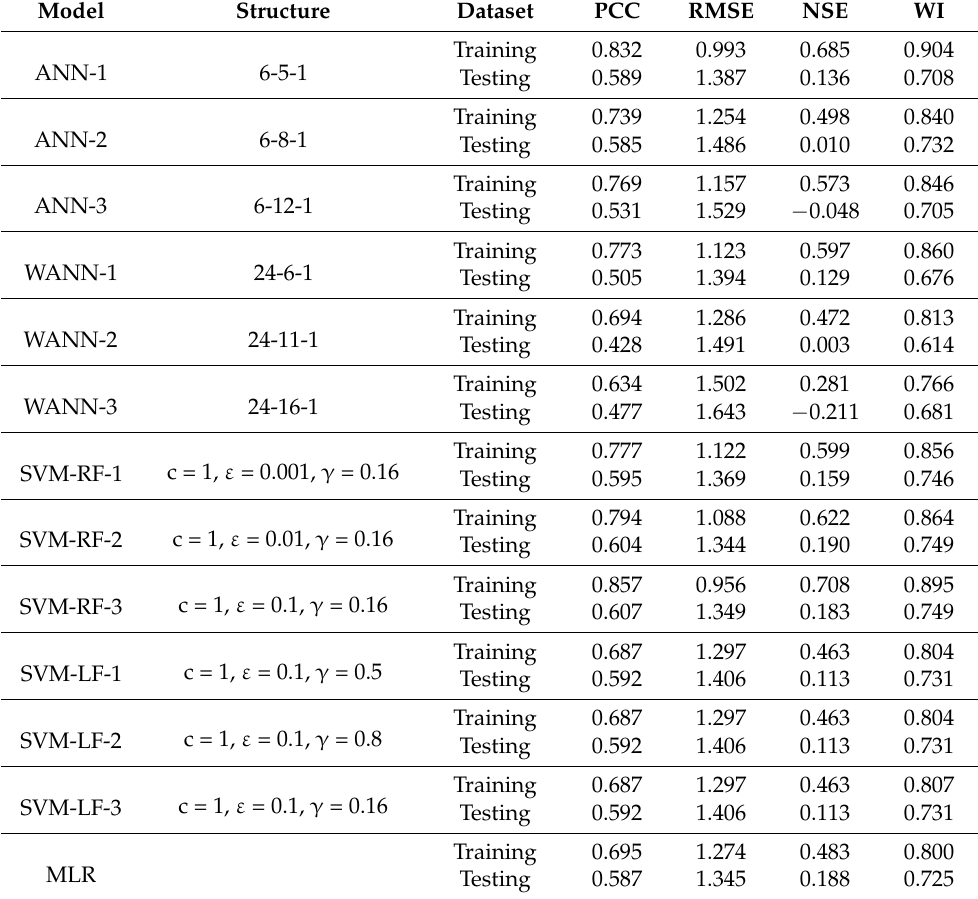
Table 4. Results for ANN, WANN, SVM-RF, SVM-LF, and M.L.R. during the training and testing period for Scenario 1 (60–40: